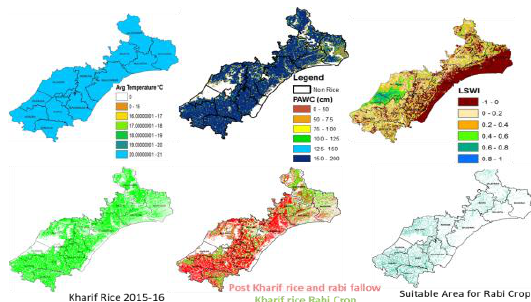
Figure 9. Kharif Rice, Rabi Fallow and Rabi suitable area for